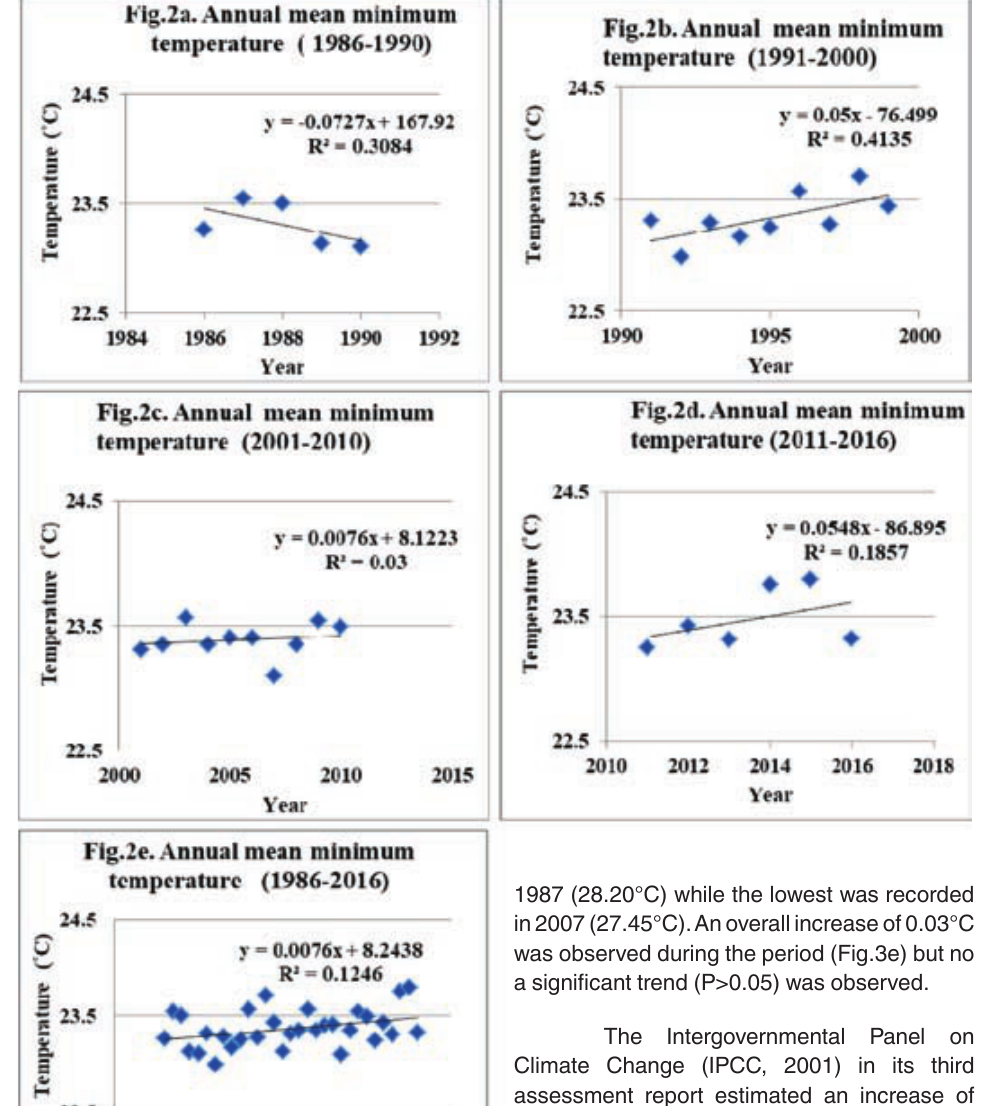
Fig.2. Trends in annual mean minimum temperature from 1986 to